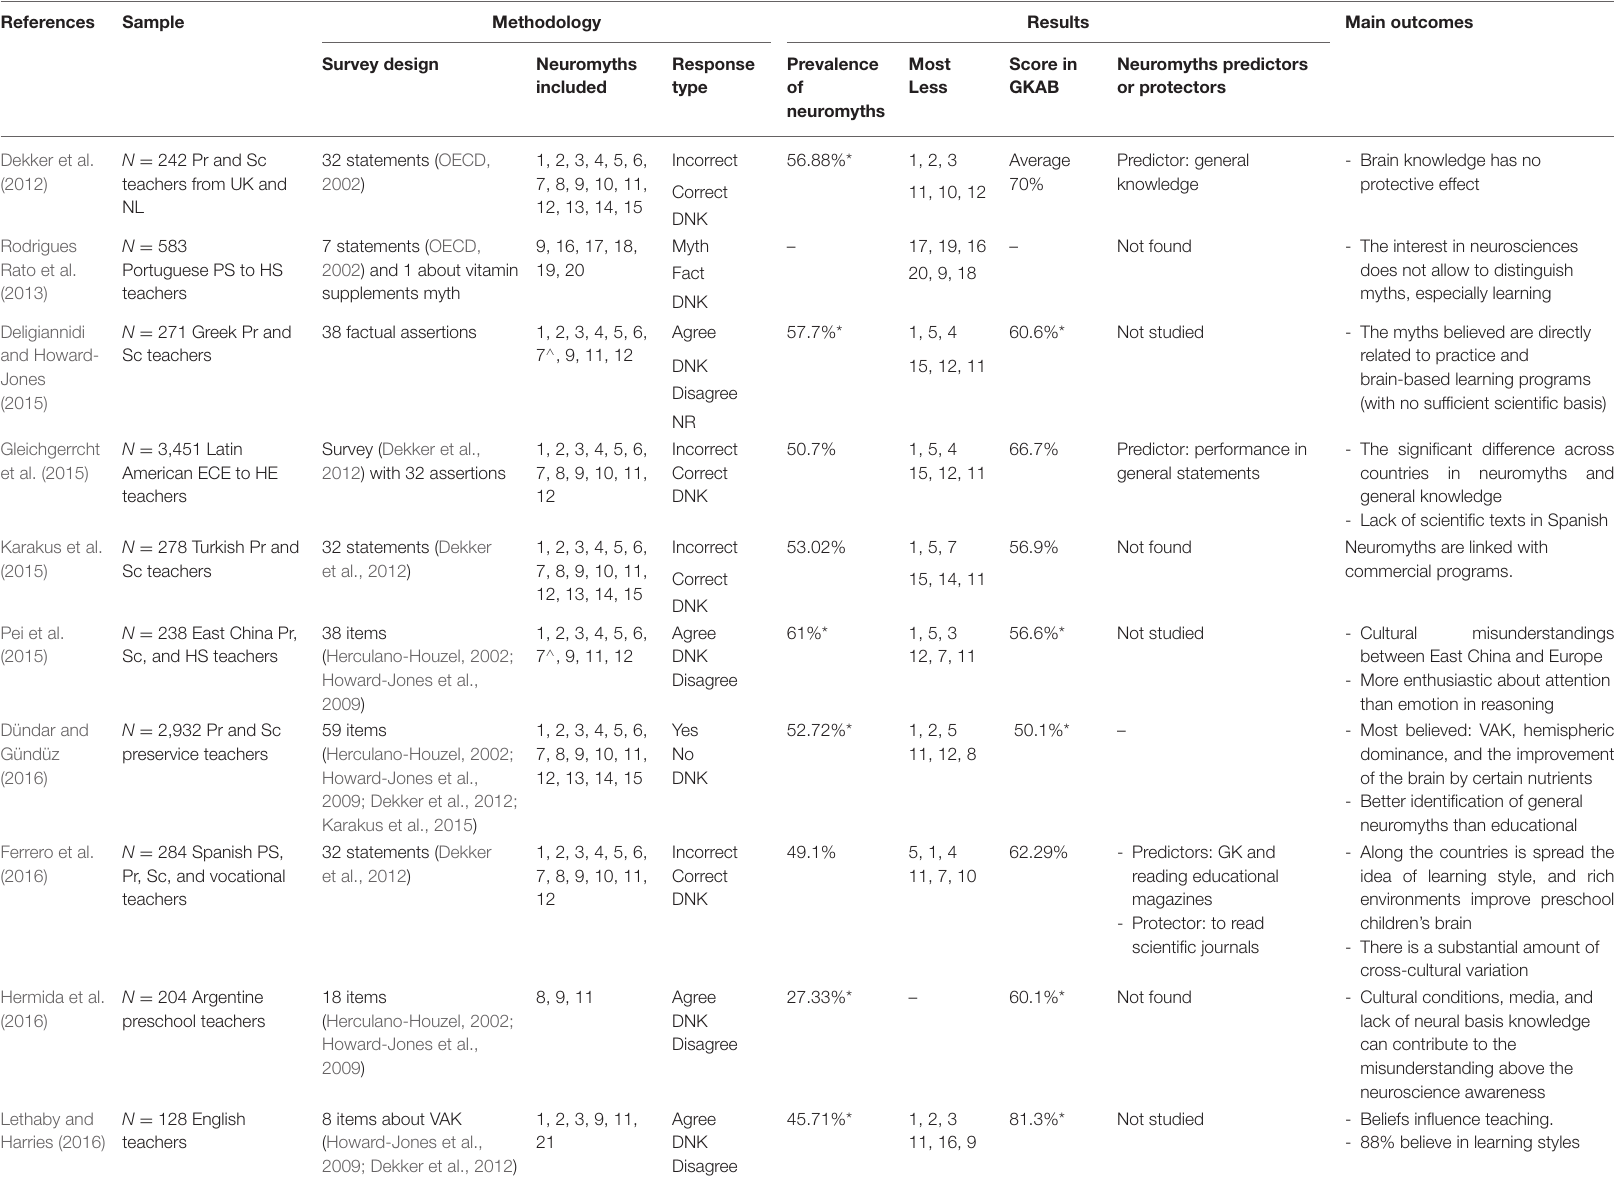
TABLE 1 | Synthesis of the investigations about